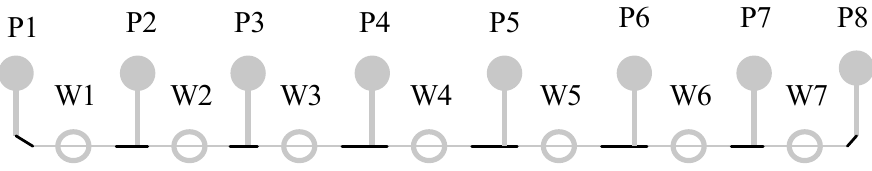
Figure 9. Schematic diagram of the distribution of detection points. Symbols W1 to W7 are cables prepared for the experiment. The vicinity of the seven- segment cable is detection point P1 to detection point P8. 5.3. The Standing Wave Trend of Short Circuit in Direct Ground Fault Is Tested The detection point P8 is set as a direct ground fault. The cables between the detection points P8 and P1 are placed from large to small. The distance between the input signal terminal and the fault point is 500 m. A signal is inputted at the detection point P1. Due to the short length of the test cable, the measurement frequency needs to be increased. Therefore, the frequency of the input signal is 10 kHz, 20 kHz, and 100 kHz, respectively. The standing wave trend corresponding to the collected data at each test point is shown in Figure 10. 600-0.50.00.51.01.52.02.53.03.54.04.55.05.56.0